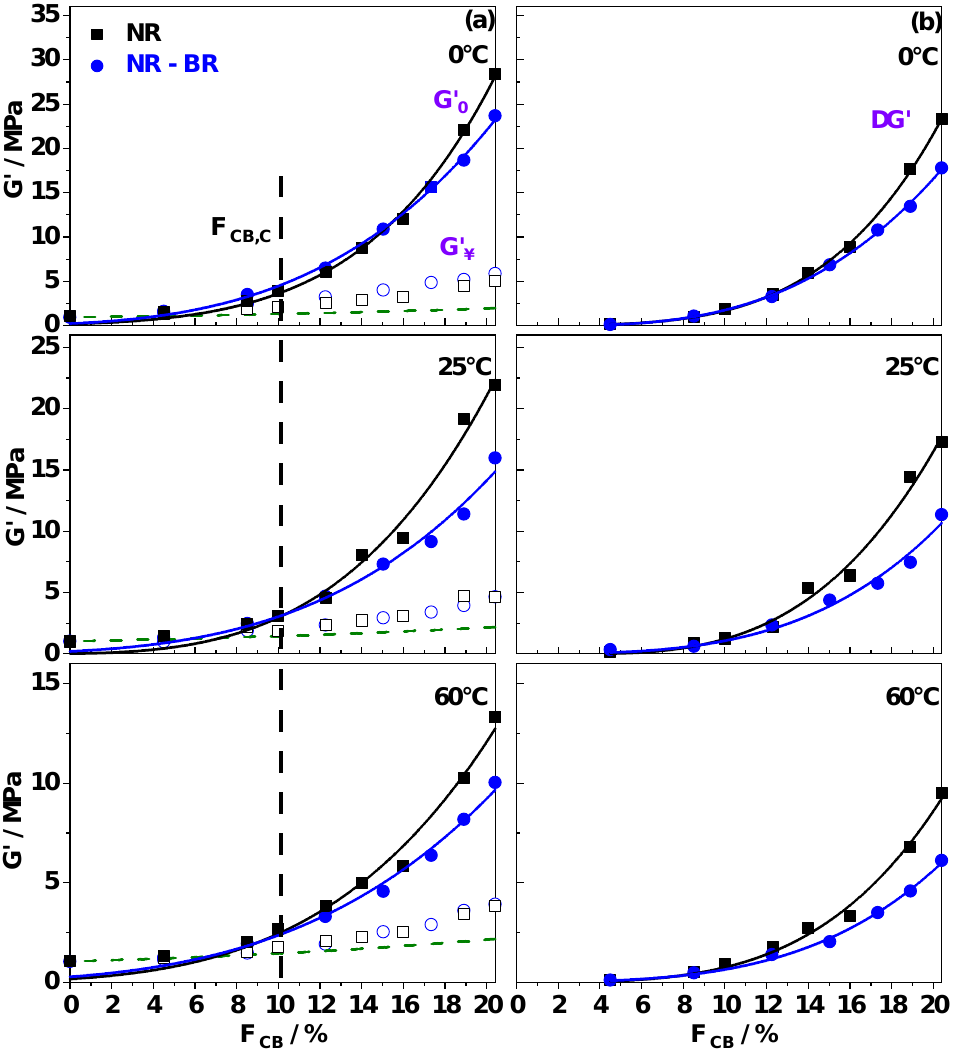
Figure 2. Filler fraction Φ CB dependent fit parameters for different temperatures. ( a ) G (cid:48) G (cid:48) ∞ (open) are Kraus fitting parameters for NR (squares) and NR-BR (circles) composites. Black dotted vertical line represents the percolation threshold Φ C , CB and green dotted line is hydrody- namic reinforcement predictions according to Guth–Gold [30]. ( b ) Strength of the filler network ∆ G (cid:48) = G (cid:48) − G (cid:48) ∞ for NR (squares) and NR-BR (Circles) composites. Lines connecting the points is a 0 guide to the